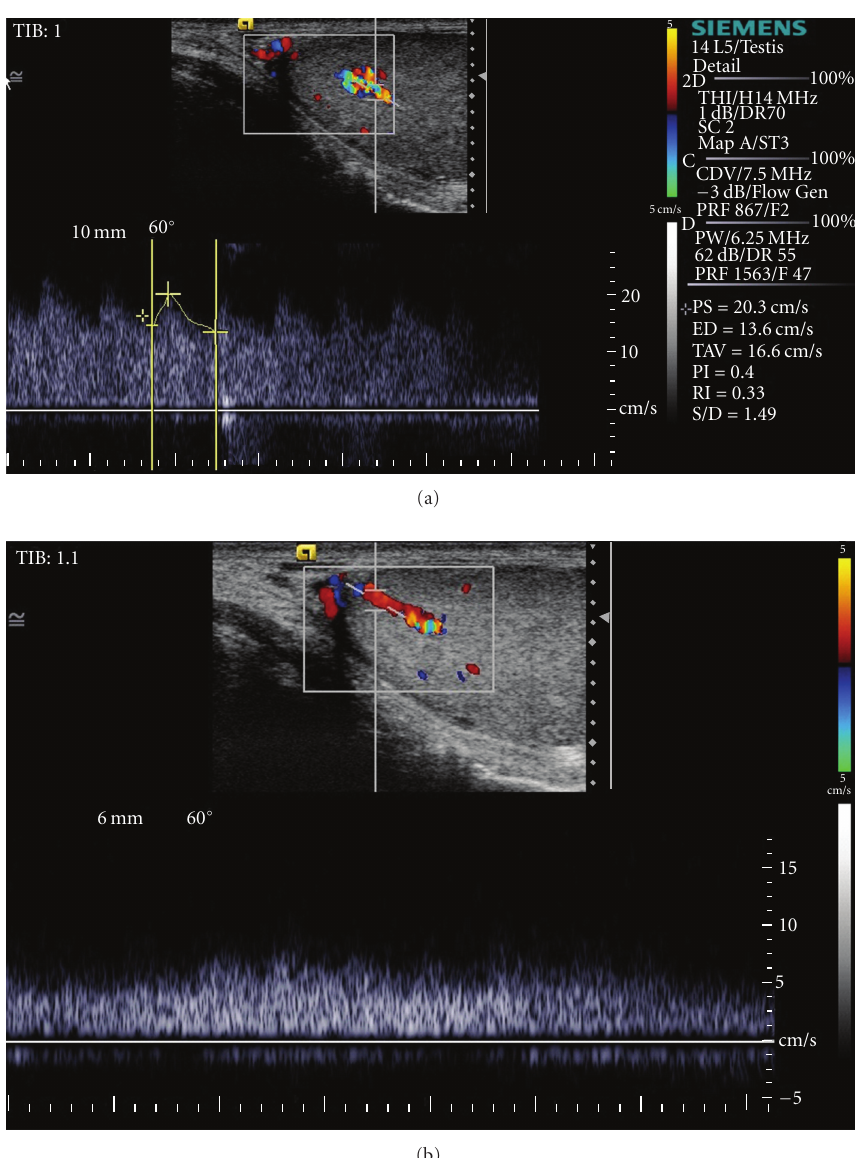
Figure 3: Spectral Doppler ultrasound depicts arterial flow in the feeding pedicle (a) and pulsatile venous flow in the drainage vessel (b).